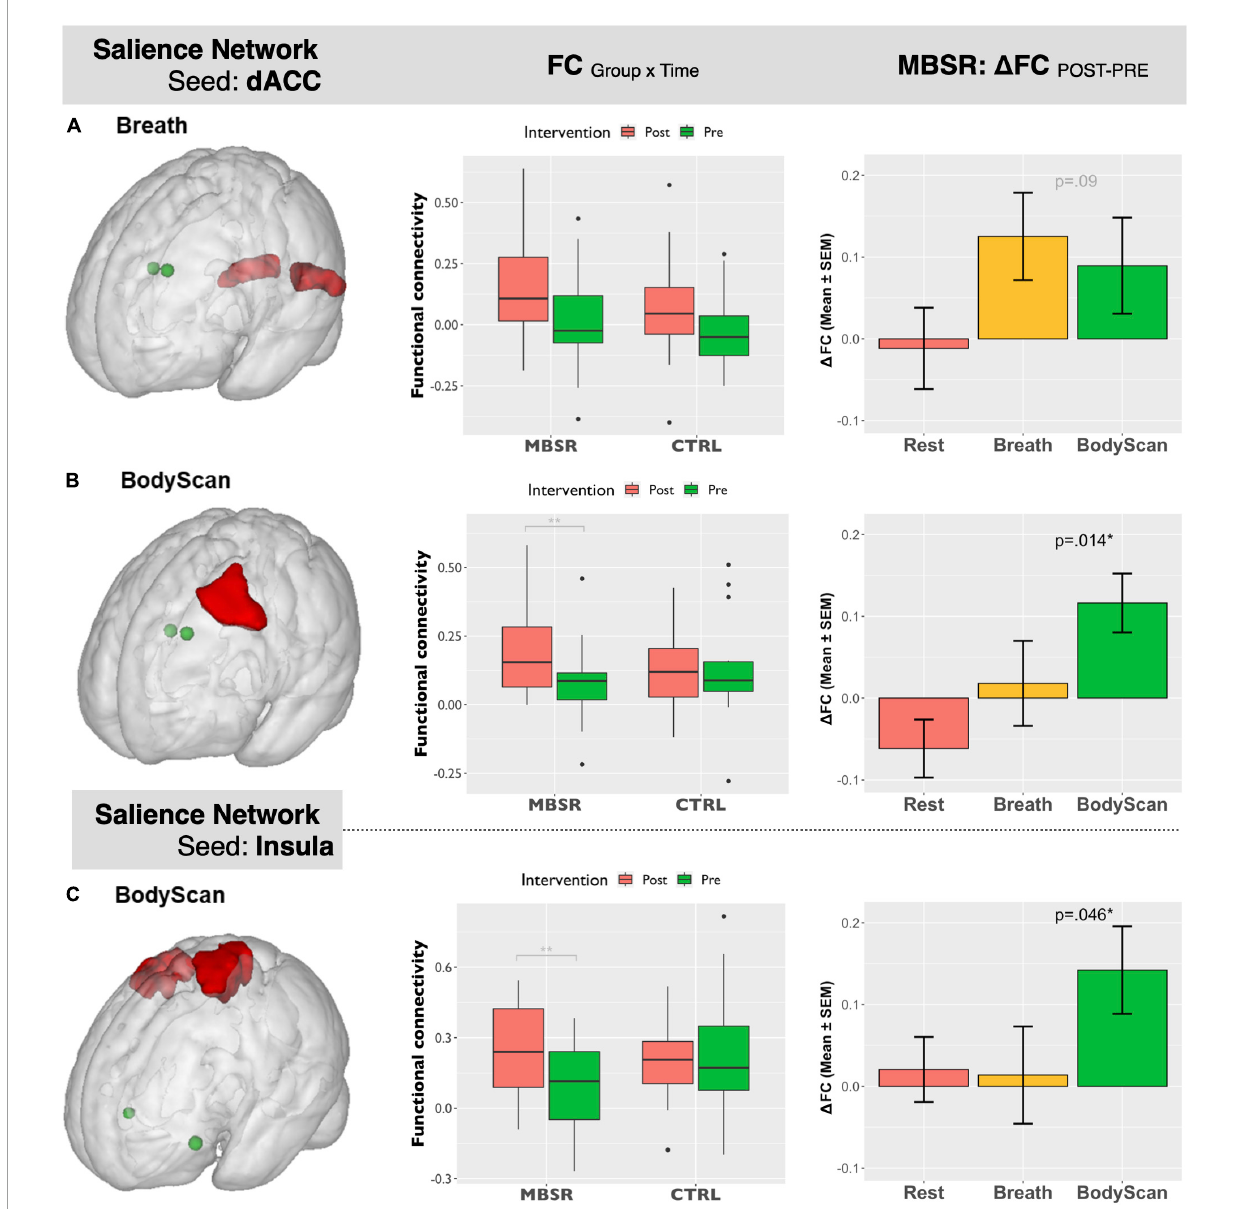
FIGURE2 Salient Network-seeding at dACC: (A) (left) ROI of bilateral occipital lobe extracted from Yeo 400 template, (middle): the ROI-based boxplot presenting the group × time interactions, and (right) the repeated-measure ANOVA of the FC changes across the 3 conditions (Rest, Breath, and BodyScan) in the MBSR group; (B) (left) ROI of the left middle frontal gyrus from Yeo 400 template, (middle): the ROI-based boxplot presenting the group × time interactions, and (right) the repeated-measure ANOVA of the FC changes in the MBSR group. Salient Network-seeding at Insula: (C) (left) ROI of bilateral pre/postcentral gyri from Yeo 400 template, (middle): the ROI-based boxplot presenting the group × time interactions, and (right) the repeated-measure ANOVA of the FC changes in the MBSR group. The error bars in the third column stands for standard error of the means